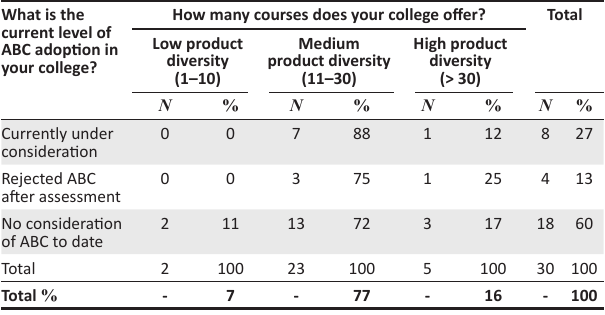
TABLE 4: Product diversity and involvement in activity-based costing adoption. What is the current level of